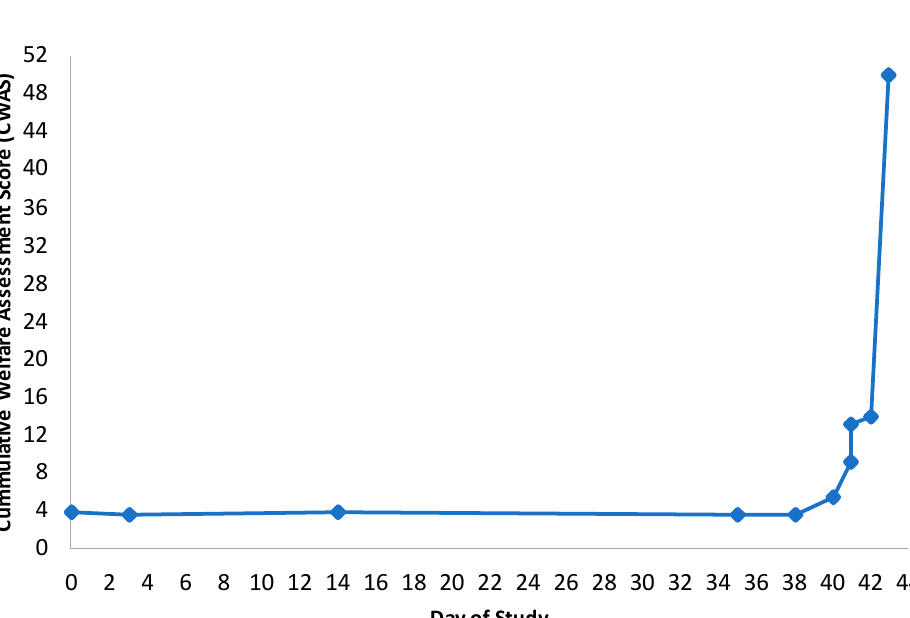
Figure 6. Cumulative Welfare Assessment Score (CWAS) timeline for porcine A, demonstrating the deterioration of welfare from being challenged with ASF on day 35, to requiring humane euthanasia on day 43. The cumulative welfare assessment scores are taken from the animal’s cruciform grids for each event. These are then plotted on the graph to display welfare over the animal’s lifetime.